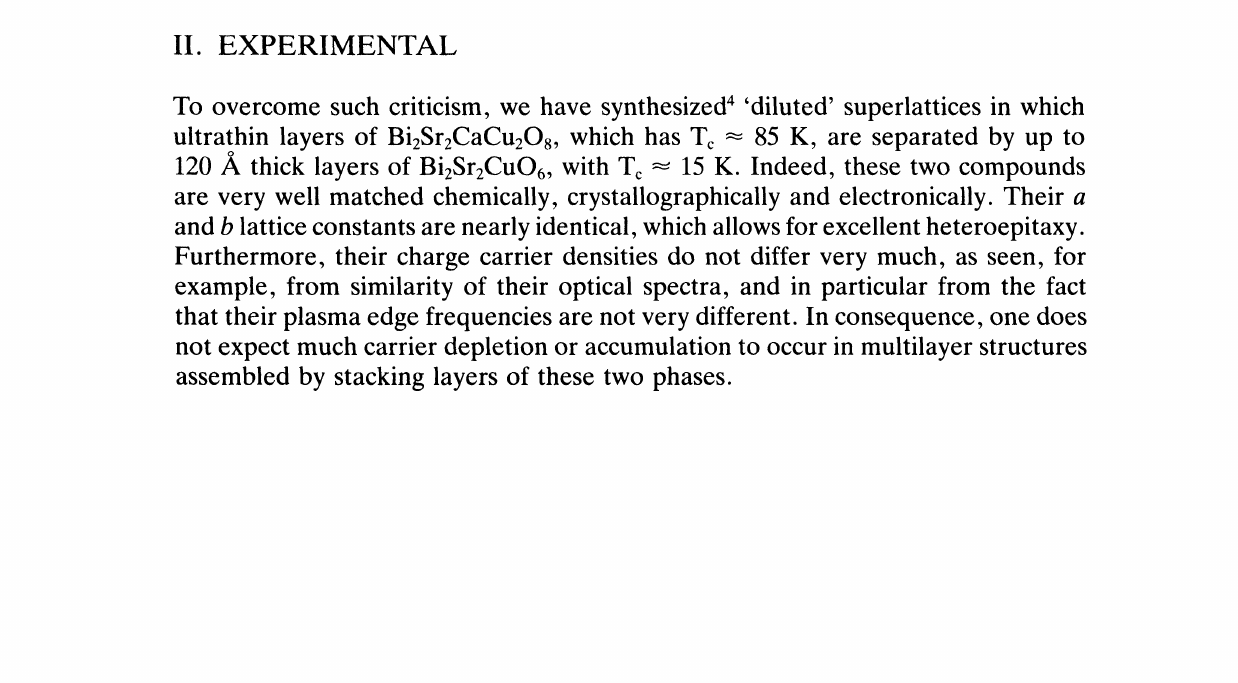
FIGURE 2 Tc as a function of n, the molecular-layer carrier density, in Lal.8sSr0 15CUO4 (L), YBazCu307 (Y,, the contribution from the CuO2 planes only, solid rectangle; Y,, the sum of both contributions from planes and chains, open rectangle), Bi2SrzCaCuzO8 (B), and Tl2Ba2Ca2Cu30o